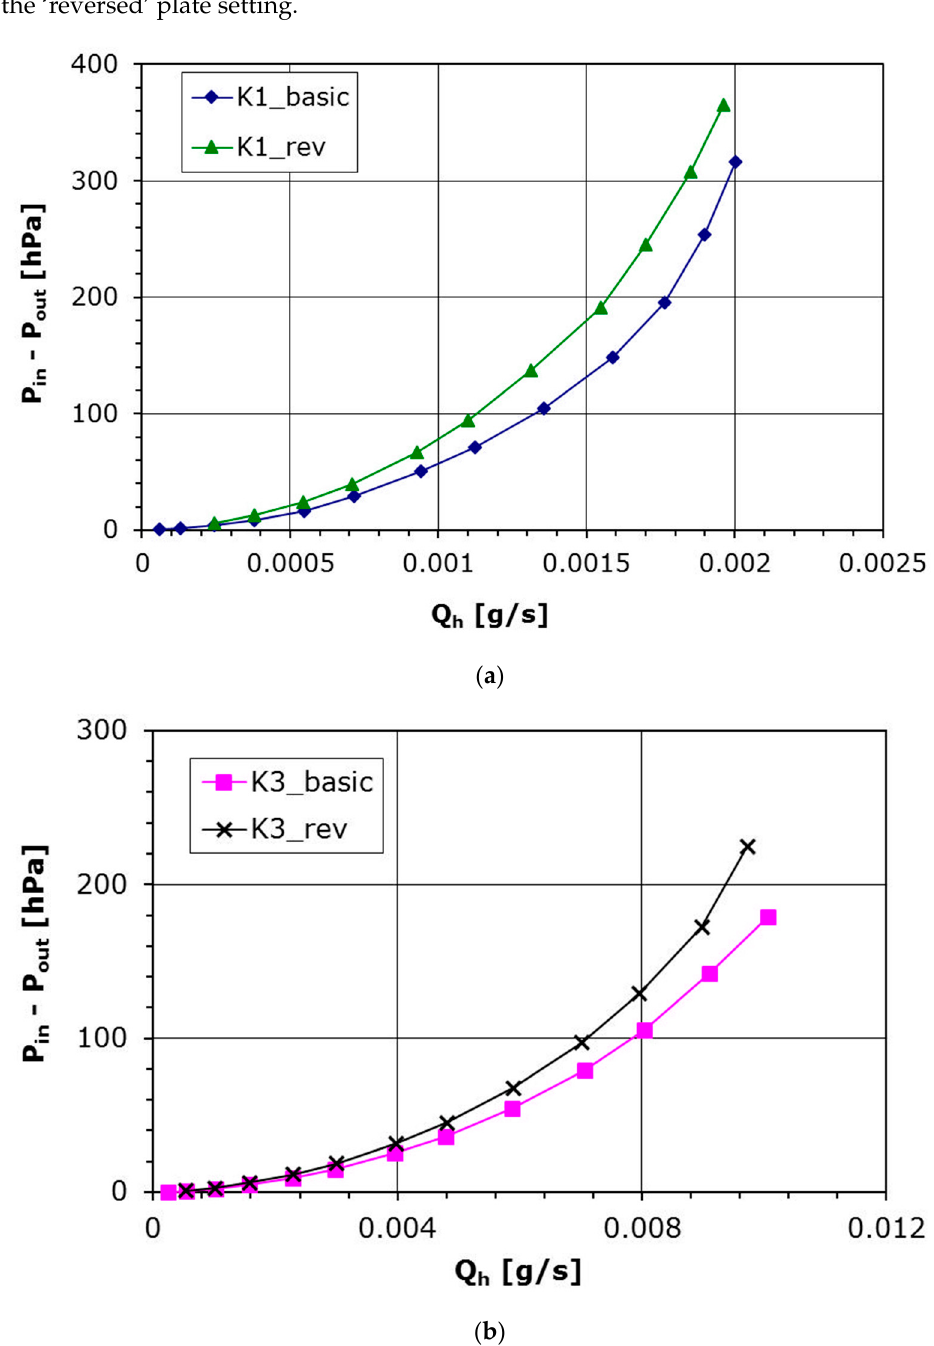
Figure 8. ( a ) Pressure difference as a function of the mass flow rate for basic and revised plate setting; Plate K1. ( b ) Pressure difference as a function of the mass flow rate for basic and revised plate setting; Plate K3.